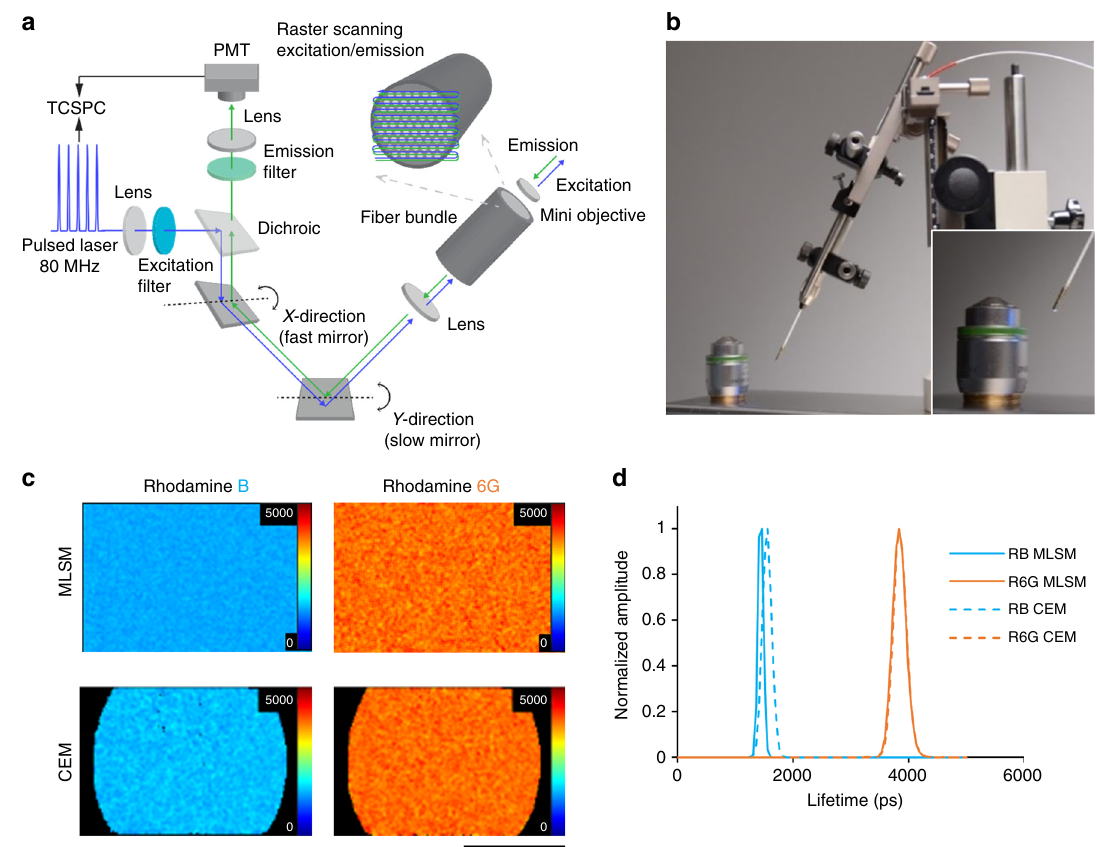
Fig. 1 Confocal micro-endoscope system. a Diagram shows the confocal endomicroscope (CEM) system. For time-domain FLIM, a Ti:Sapphire laser operating at 80 MHz is frequency-doubled to generate excitation light at 488 nm. A 720 nm short pass fi lter rejects the infrared fundamental wavelength at 976 nm. The excitation is introduced into the confocal excitation/imaging path via a 505 nm long pass dichroic beamsplitter and directed to a resonant scanner for rapid line scanning and a galvanometric mirror for frame scanning. The scanned excitation laser beam is focused onto a coherent fi ber-optic bundle such that it sequentially addresses single cores in the fi ber-optic bundle, which has a diameter of ~1 mm with ~30,000 cores. At the distal tip of the coherent fi ber-optic bundle, a mini-objective lens of 2.6 mm diameter images each illuminated fi ber core onto the sample plane and the fl uorescence signal from the sample is imaged back onto the same core of the distal end of the fi ber-optic bundle. This implements optically sectioned confocal imaging with the core serving as the confocal pinhole. At the proximal end of the fi ber-optic bundle the fl uorescence signal is descanned and focused onto a confocal aperture in front of a photon-counting photomultiplier. Photodetection events are recorded via a TCSPC card (B&H SPC830) that associates a photon arrival time relative to the phase of the scanning unit mirrors and arrival of the excitation laser pulses. Thus, histograms of photon arrival times are assigned to each image pixel and subsequently used to generate a fl uorescence lifetime image. TCSPC count rates are ≤ 10 6 Hz. b Photograph of the confocal endomicroscope alongside a 20× multiphoton microscope objective (Carl Zeiss, objective Plan-Apochromat 20× /0.8, M27, model# 420650-9901-000), showing their relative size. c Fluorescence lifetime images of aqueous solutions (10 µ M) of Rhodamine B (RB) and Rhodamine 6G (R6G) made using a conventional TCSPC FLIM microscope (MLSM) (Zeiss LSM-780 NDD multiphoton FLIM) and the CEM. The FLIM images are uniform as expected from a homogenous sample. d Fluorescence lifetime histograms corresponding to the FLIM images shown in c . The solid and dashed lines represent the MLSM and CEM FLIM data,